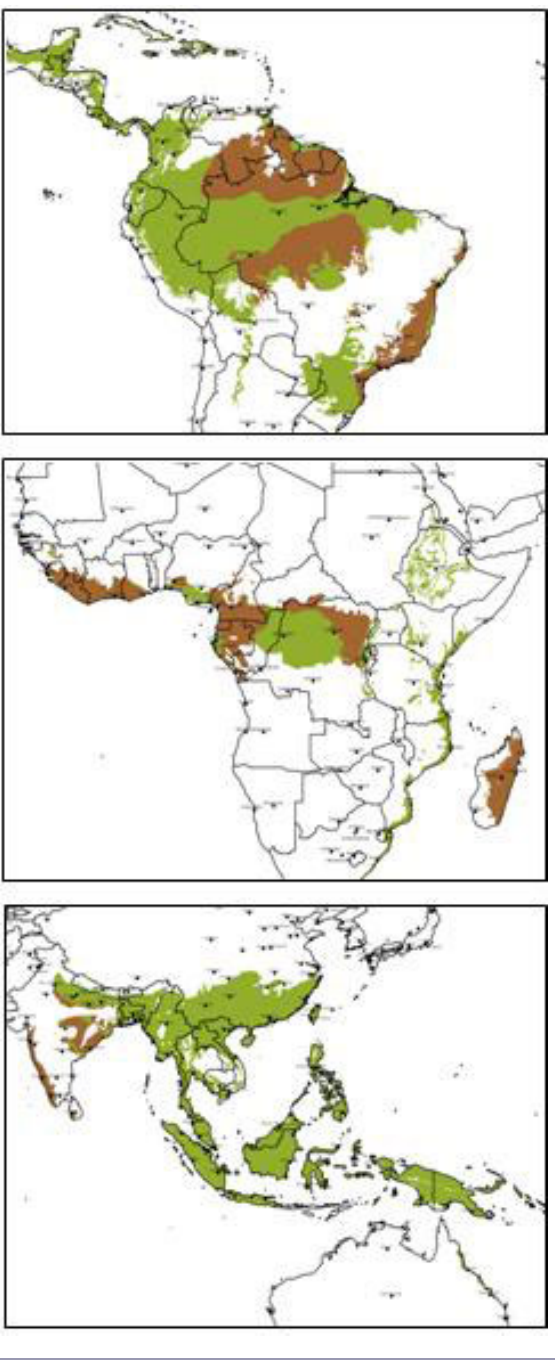
Fig. 2. Tropical closed broadleaved forests and the distribution of these occurring on Phanerozoic (green) and exposed Precambrian terranes (brown) in South and Central America, Africa, and Asia— Oceania prior to losses accrued through modern deforestation. See Methods for details of